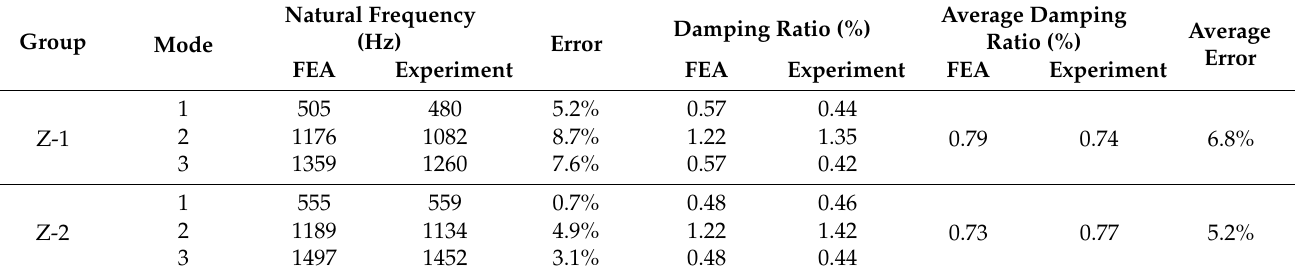
Figure 9. Modal testing system. Table 6. Testing results of the free vibration.